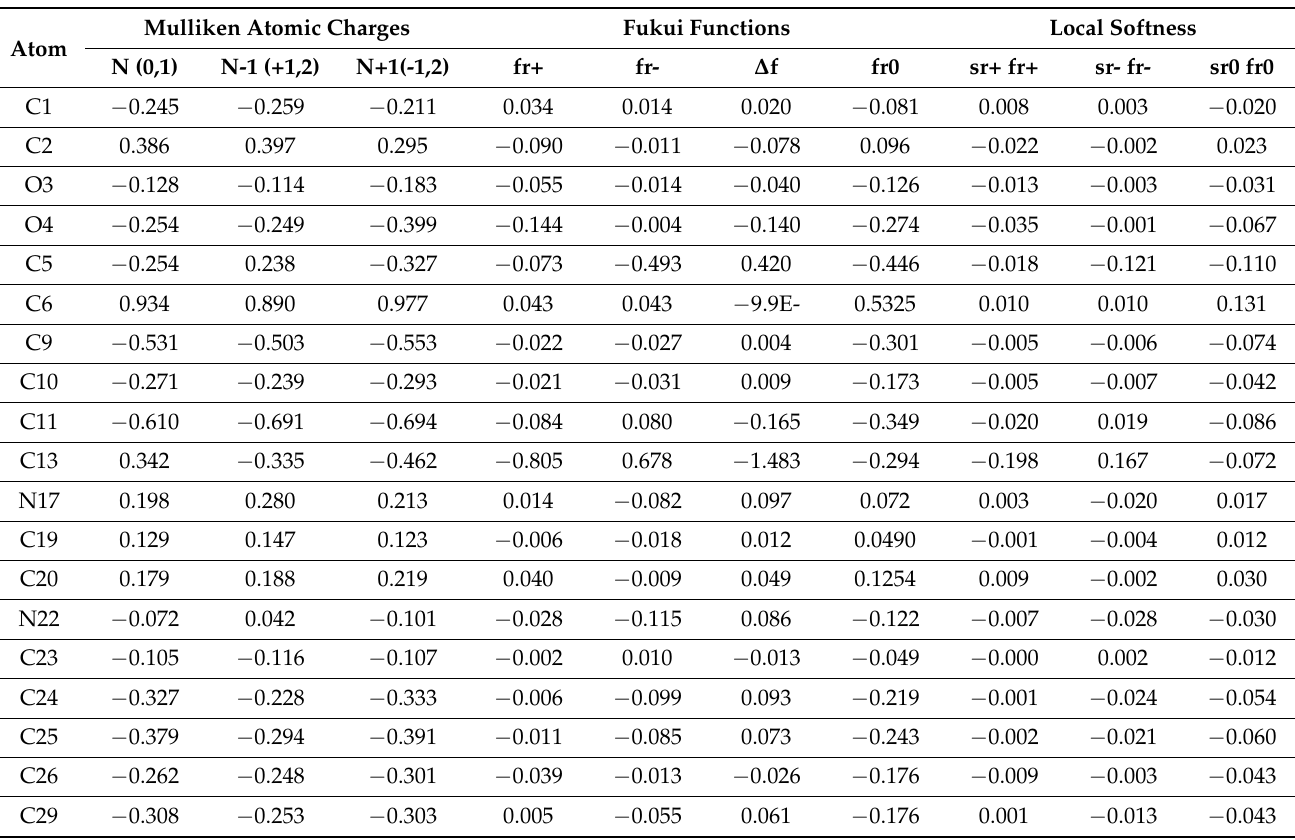
Table 3. Mulliken Atomic Charge distribution, Fukui Functions and Local Softness equivalent